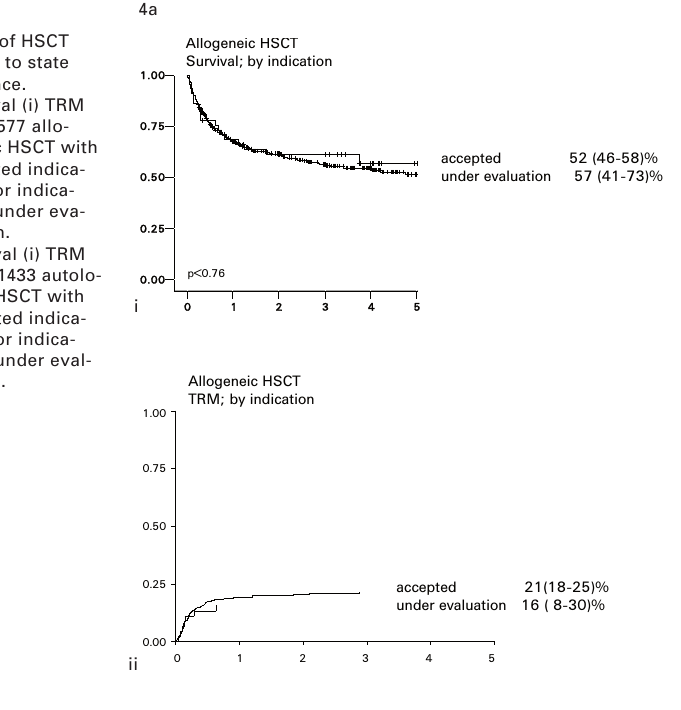
Outcome of HSCT according to state of insurance. 4a: Survival (i) TRM (ii) of 577 allo- geneic HSCT with accepted indica- tions or indica- tions under eva- luation. 4b: Survival (i) TRM (ii) of 1433 autolo- gous HSCT with accepted indica- tions or indica- tions under eval-